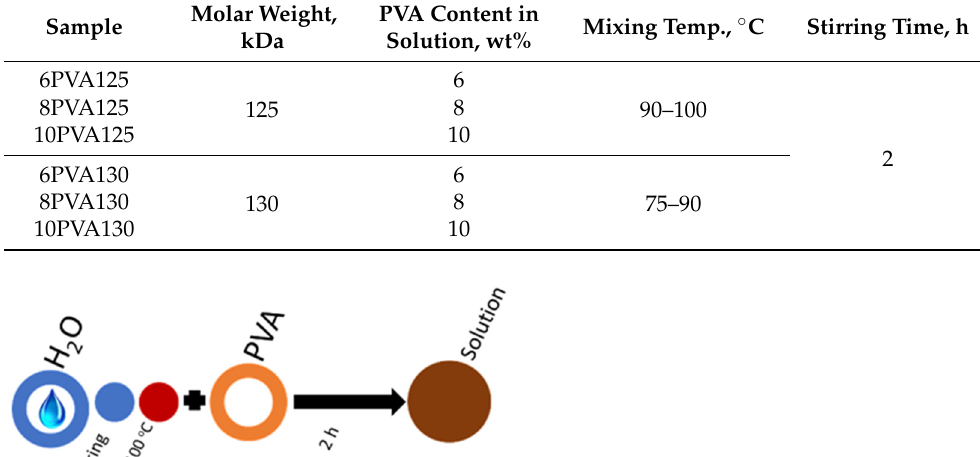
Table 8. The time and temperature used for PVA solutions preparation.